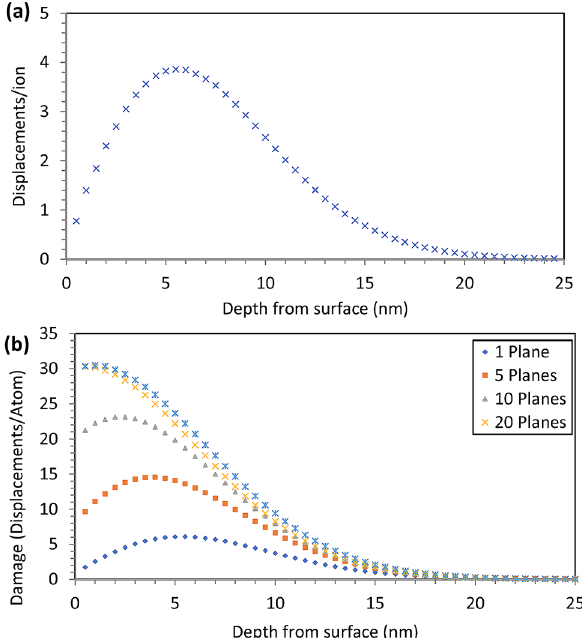
Figure 6. ( a ) Graph showing the irradiation damage distribution with depth after a 16 keV Cs atom strikes a Zry-4 target, as modelled by SRIM. ( b ) Shows the accumulation of damage in a Zy-4 target for increasing